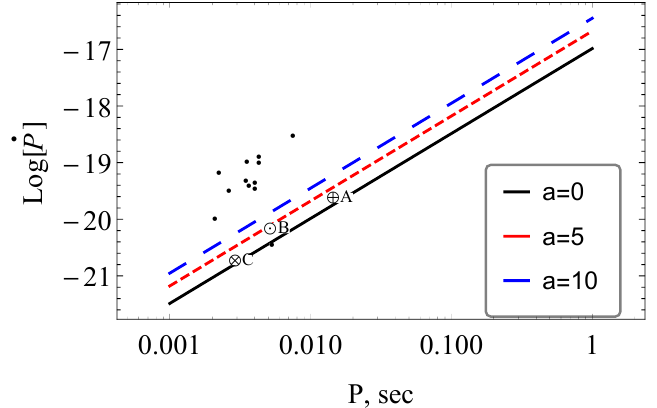
Figure 8. Position of the death line for NSs in the P ˙ P space for various values of the EU parameter and the fixed value of compactness parameter (cid:101) = 0.2. A, B and C points imply the positions of pulsars J 2145-0750, J 0024-7204 D and J 0024-7204 H,